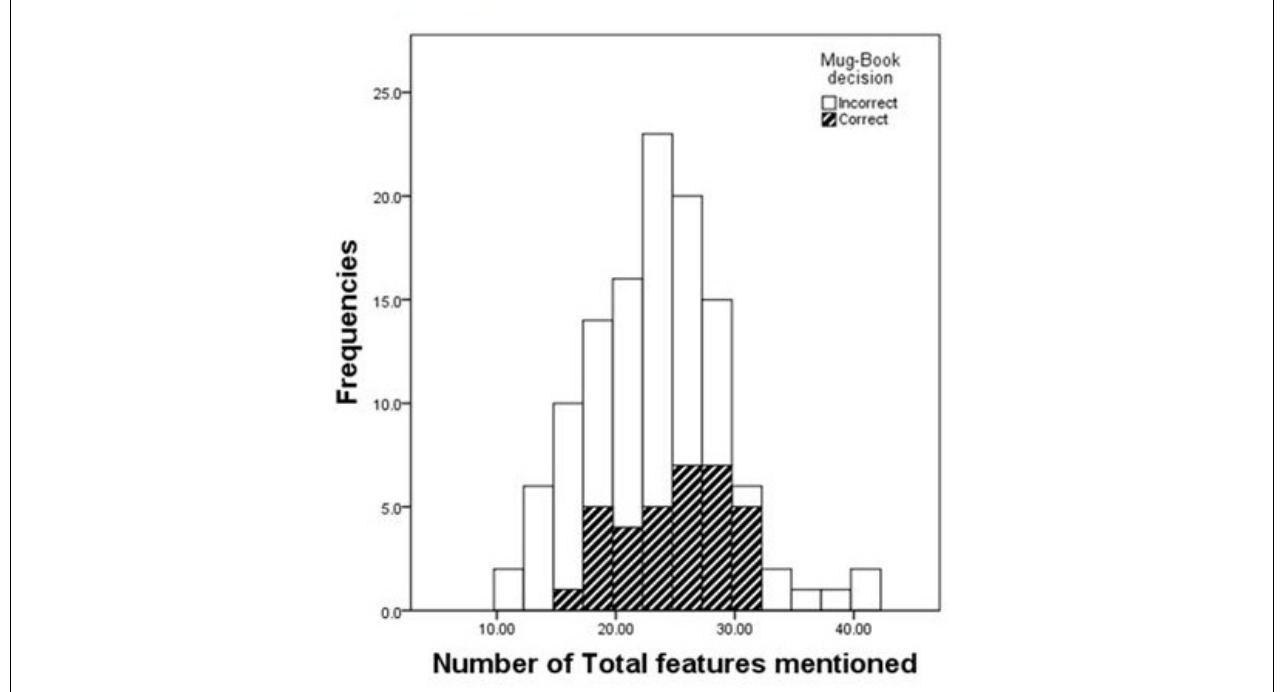
FIGURE 3 | Distribution of the number of features mentioned for correct and incorrect mugbook decisions. Frequencies represent the number of witnesses that mentioned the number of features.